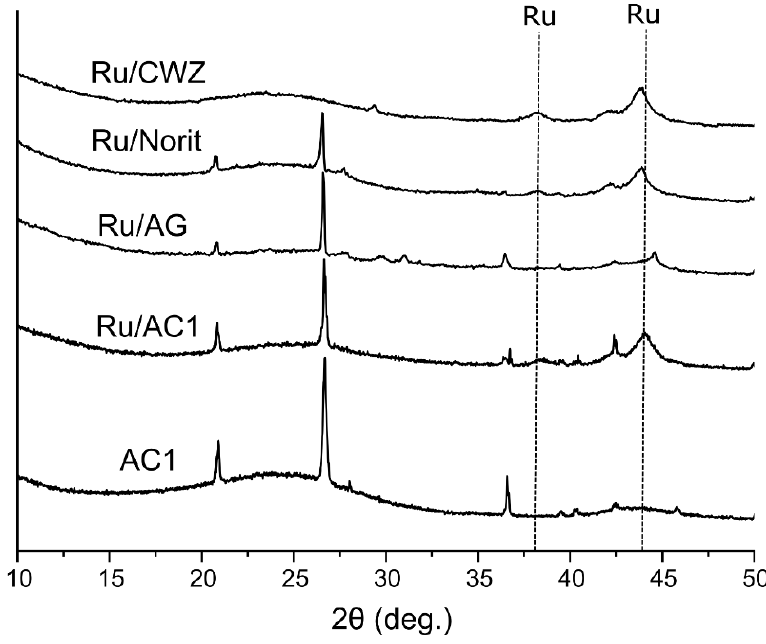
Figure 4. XRD pattern of AC1 support and ruthenium catalysts.